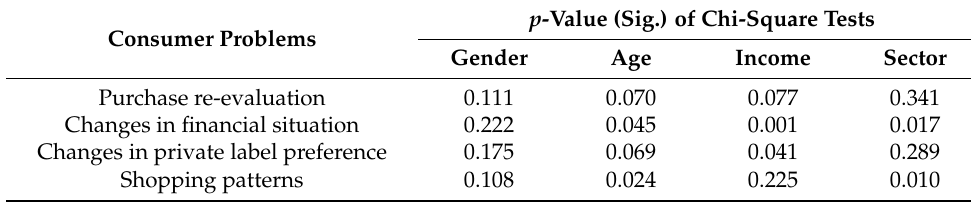
Table 2. Outputs of the Pearson’s chi-square